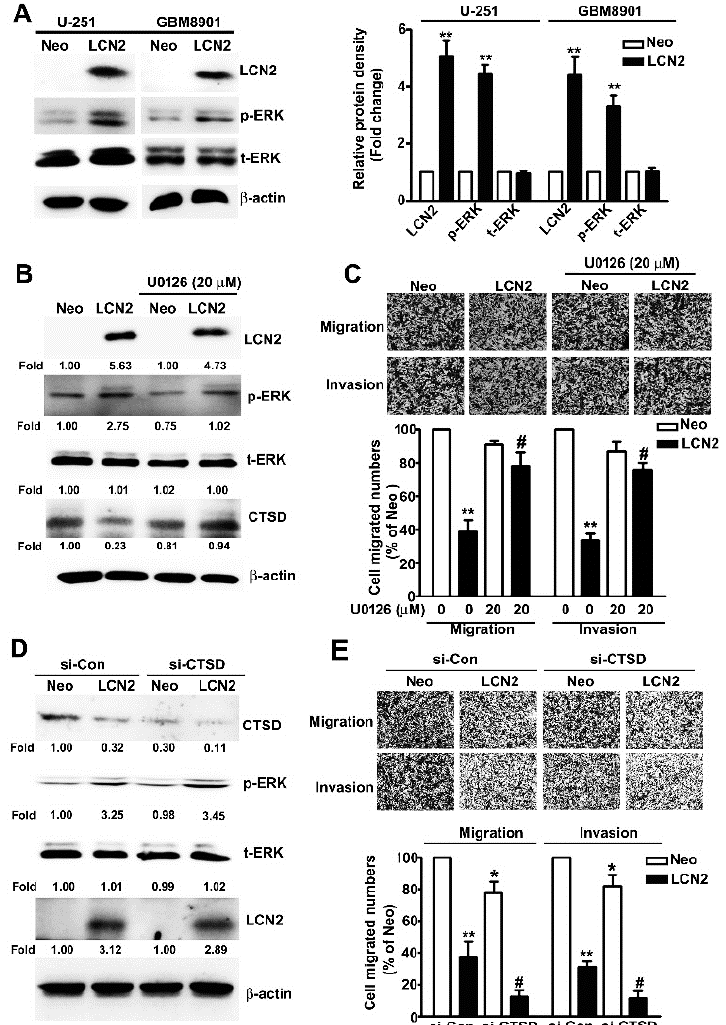
Figure 5. Effect of LCN2 overexpression on ERK-targeted CTSD expression. ( A ) Western blot analysis of total lysates of LCN2-overexpressing or Neo-GBM8901 and U-251 cells to determine the protein expression of LCN2, p-ERK, and t-ERK (left panel). ( B ) Western blot analysis of the same cells were treated with the MEK inhibitor U0126 (20 µ M) for 2 h to determine the protein expression of LCN2, p-ERK, t-ERK, and CTSD (right panel). ( C ) The migration and invasiveness of cells following treatment with or without U0126 (20 µ M) in LCN2-overexpressing or Neo-U-251 cells. ( D ) Transfection with si-Con or si-CTSD in LCN2-overexpressing or Neo-U-251 cells for 48 h, then extracted the total proteins and measured by western blot. ( E ) The migration and invasiveness of cells following transfected with si-Con or si-CTSD in LCN2-overexpressing or Neo-U-251 cells. β -actin was used as an internal control for protein loading Data are presented as the mean ± SE of at least three independent experiments. * p < 0.05, ** p < 0.01 compared with Neo cells or si-Con in Neo overexpressing cells. # p < 0.05, compared with LCN2-overexpressing cells or si-Con in LCN2 overexpressing cells.